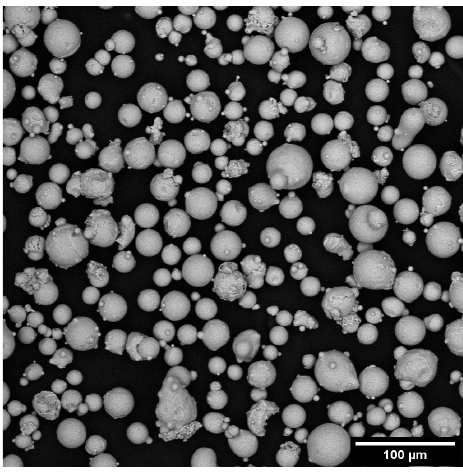
Figure 1. Typical SEM-BSE image of powder particles optimized for the analysis.